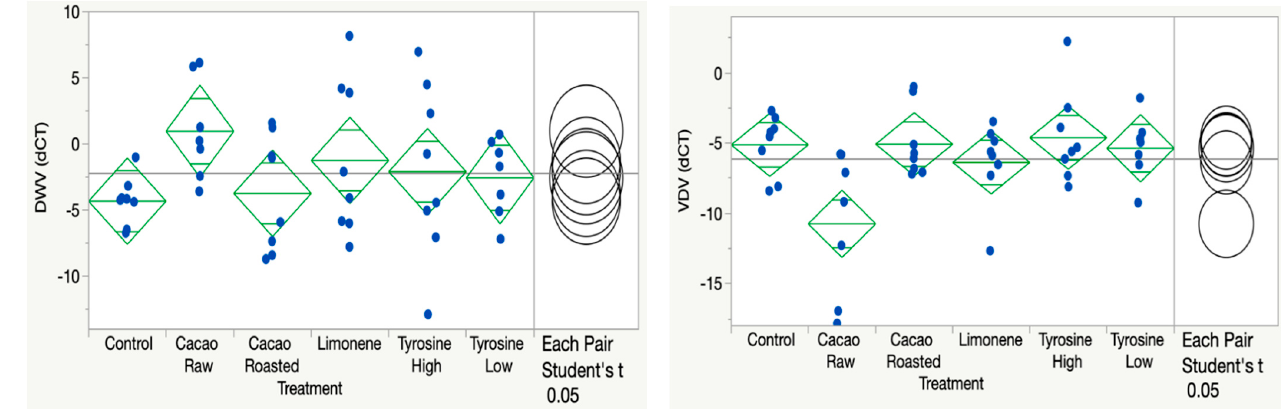
Figure 3. One-way analysis of DWV and VDV by treatment. The control was fed sugar water only. Treatments were dissolved in sugar water as described in the Methods section. The diamond tips represent the 95% confidence intervals for the ANOVA, with the mean designated with the middle horizontal line across each diamond. Increased values indicate an increased viral load. Student’s t -test. Comparison circles shown means, where circles that overlap are not significantly different, whereas circles that do not overlap are significantly different.